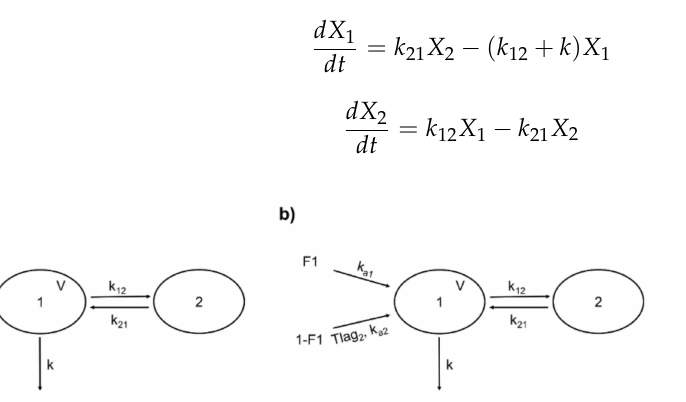
Figure 3. Structure of the population pharmacokinetic (popPK) models for rutin and quercetin conjugates (as quercetin). ( a ) Two-compartment model for intravenous rutin. 1: central compartment; 2: peripheral compartment; V: central compartment volume; k: first-order elimination rate constant; k 12 : rate constant of distribution from 1 to 2; k 21 : rate constant of distribution from 2 to 1. ( b ) Double absorption and two-compartment model for quercetin conjugates from oral rutin. F1: absorbed fraction from the first site; 1-F1: absorbed fraction from the second site; ka 1 : first-order absorption rate constant from the first site; ka 2 : first-order absorption rate constant from the second site; Tlag 2 : delay for the second absorption; other parameters are identical to ( a